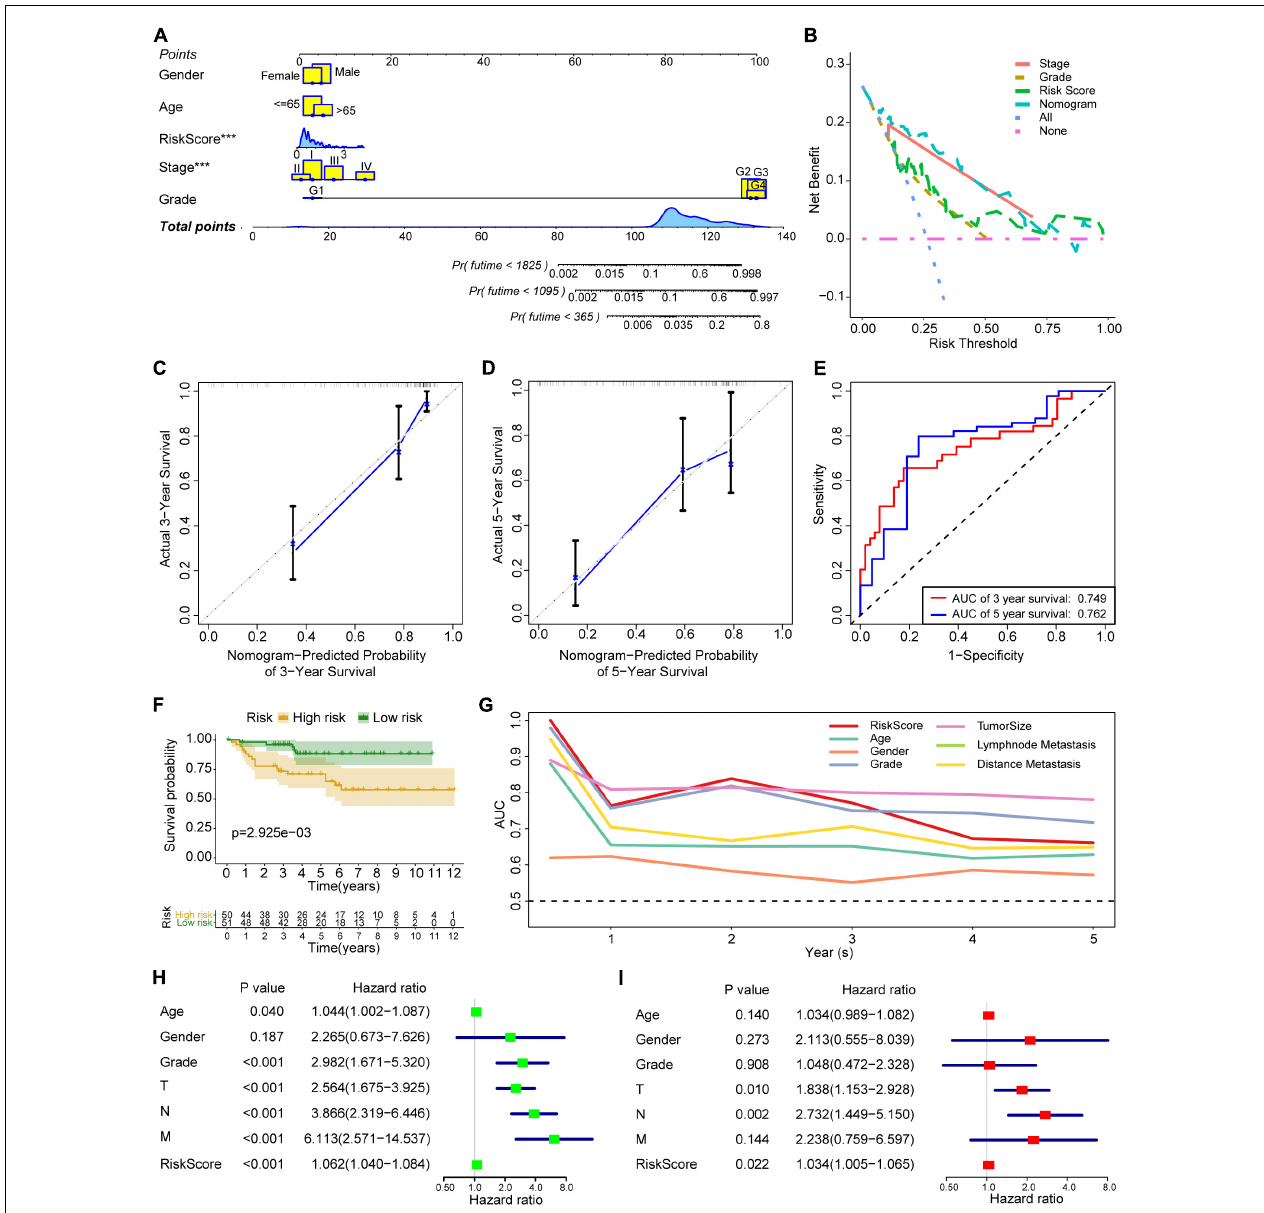
FIGURE 7 | The construction and validation of nomogram and the validation of acetylation-related score. (A) The nomogram including age, gender, grade, stage, and acetylation-related score. (B) The results of decision curve analysis. (C,D) Calibration plot for 3 and 5 years. (E) ROC analysis for 3 and 5 years. (F) Survival analysis of acetylation-related score from validation dataset. (G) ROC analysis from validation dataset. (H,I) The results of univariate and multivariate Cox regression analysis from validation dataset. *** p < 0.001.